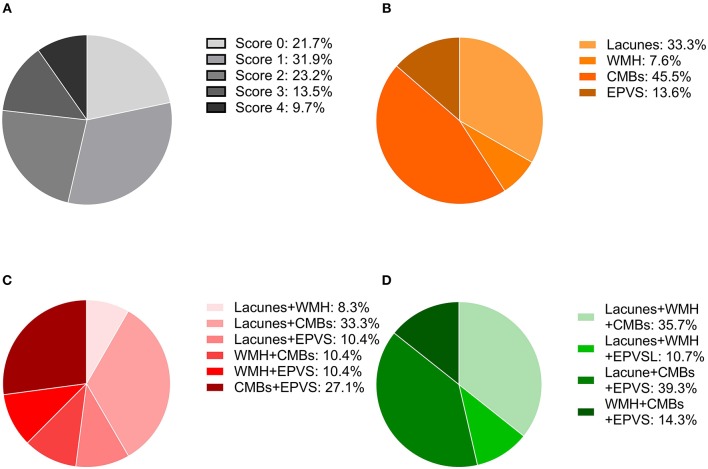
Distribution of the total SVD score and composition of the different scores. (A) Frequency of each score in the whole cohort. (B) Percentage of each lesion when the SVD score was one. (C) Percentages of the combinations of two lesions when the SVD score was two. (D) Percentages of the combinations of three lesions when the SVD score was three.